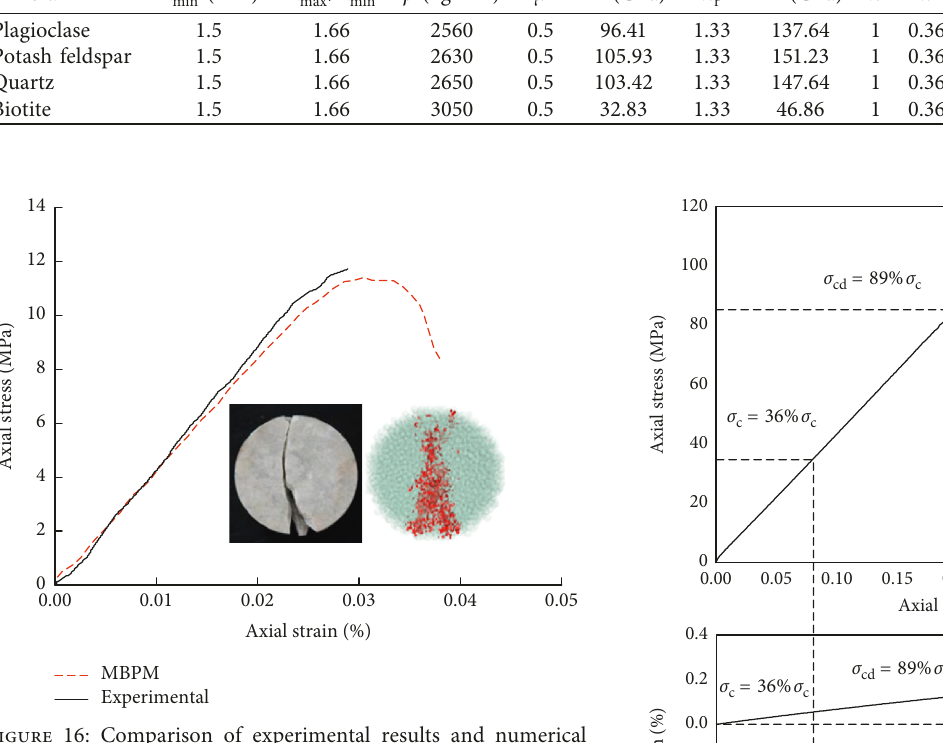
Figure 16: Comparison of experimental results and numerical results on the Brazilian disc test.